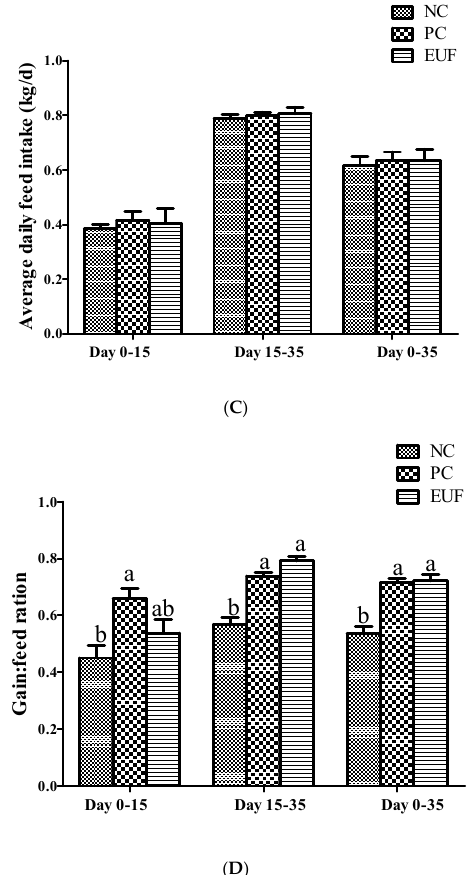
Figure 1. Growth performance: ( A ) body weight; ( B ) average daily gain; ( C ) average daily feed intake; ( D ) gain Z: feed ration; NC = negative control, low-protein basal diet no antibiotics included; PC = positive control, low-protein basal diet + antibiotics (75 mg/kg quinocetone, 20 mg/kg virginomycin, and 50 mg/kg aureomycin); EUF = Eucommia ulmoides flavones, low-protein basal diet + 0.01% EUF. Values are the mean ± SEM, n = 8 per treatment group. a,b Values with different letters are significantly different ( p < 0.05).